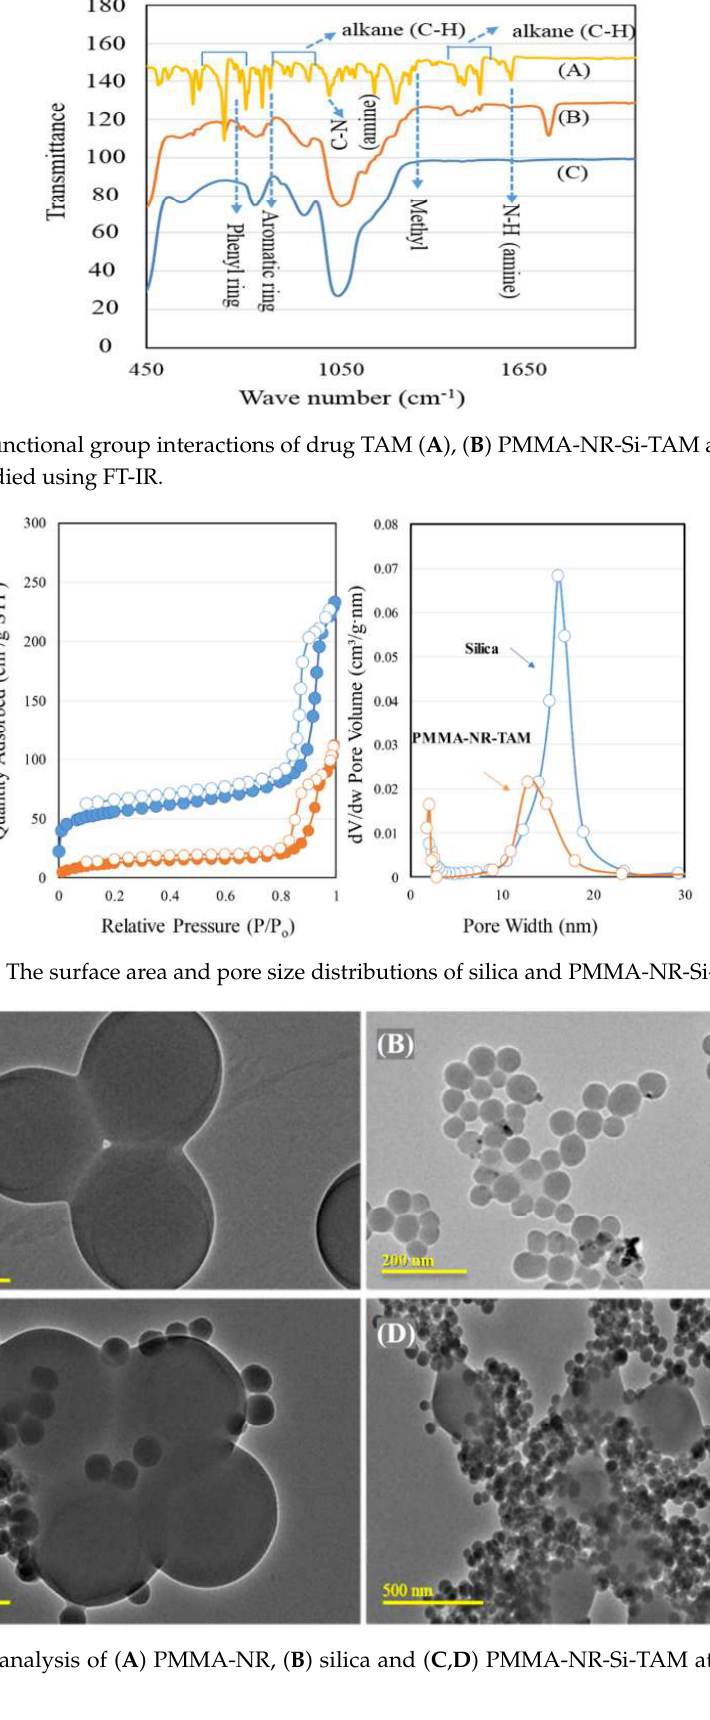
Figure 3. The functional group interactions of drug TAM ( A ), ( B ) PMMA-NR-Si-TAM and ( C ) silica, which were studied using FT-IR.